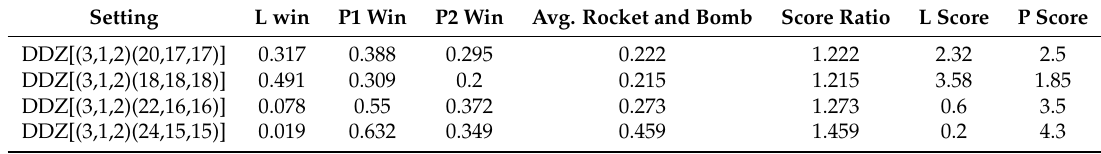
Table 4. Possible scores of landlord and peasant with different card distribution